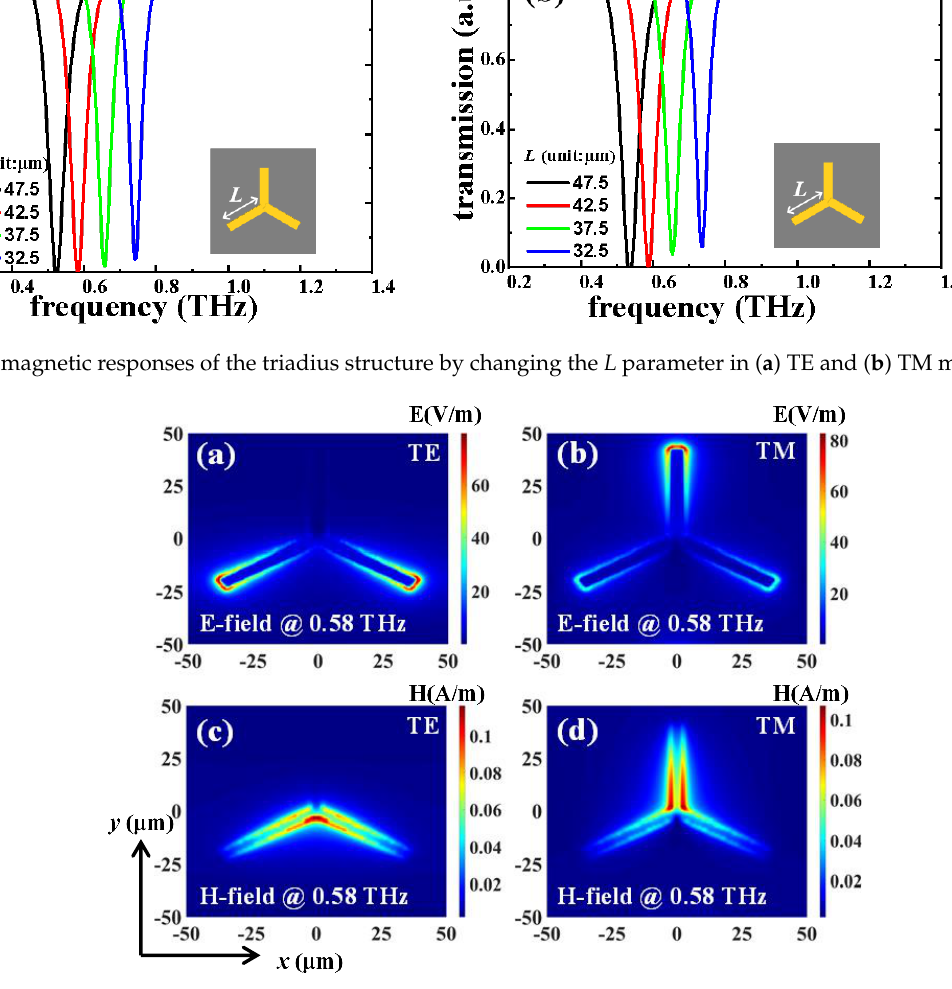
Figure 3. Field distributions of the triadius structure with L = 42.5 μm in TE and TM modes. ( a ) and ( b ) are E-field distributions. ( c ) and ( d ) are H-field distributions.